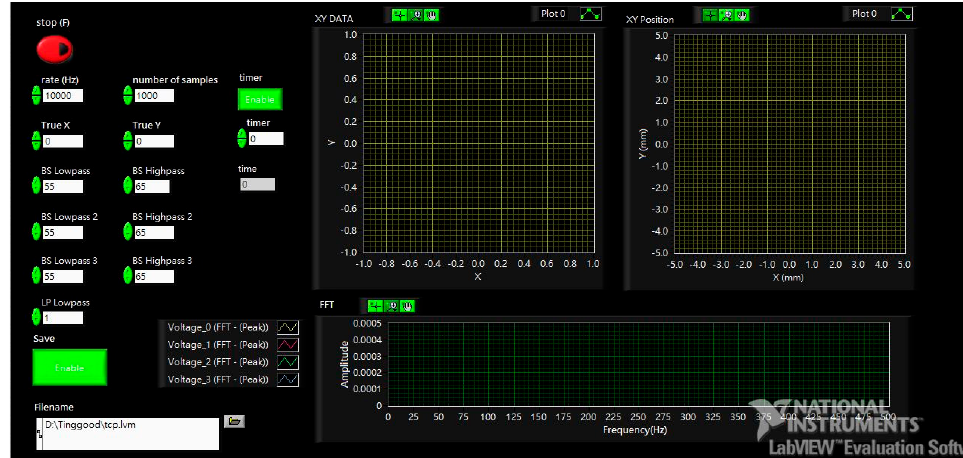
Figure 18. Design an HMI to observe the TCP contour motion based on TCP − OMS.